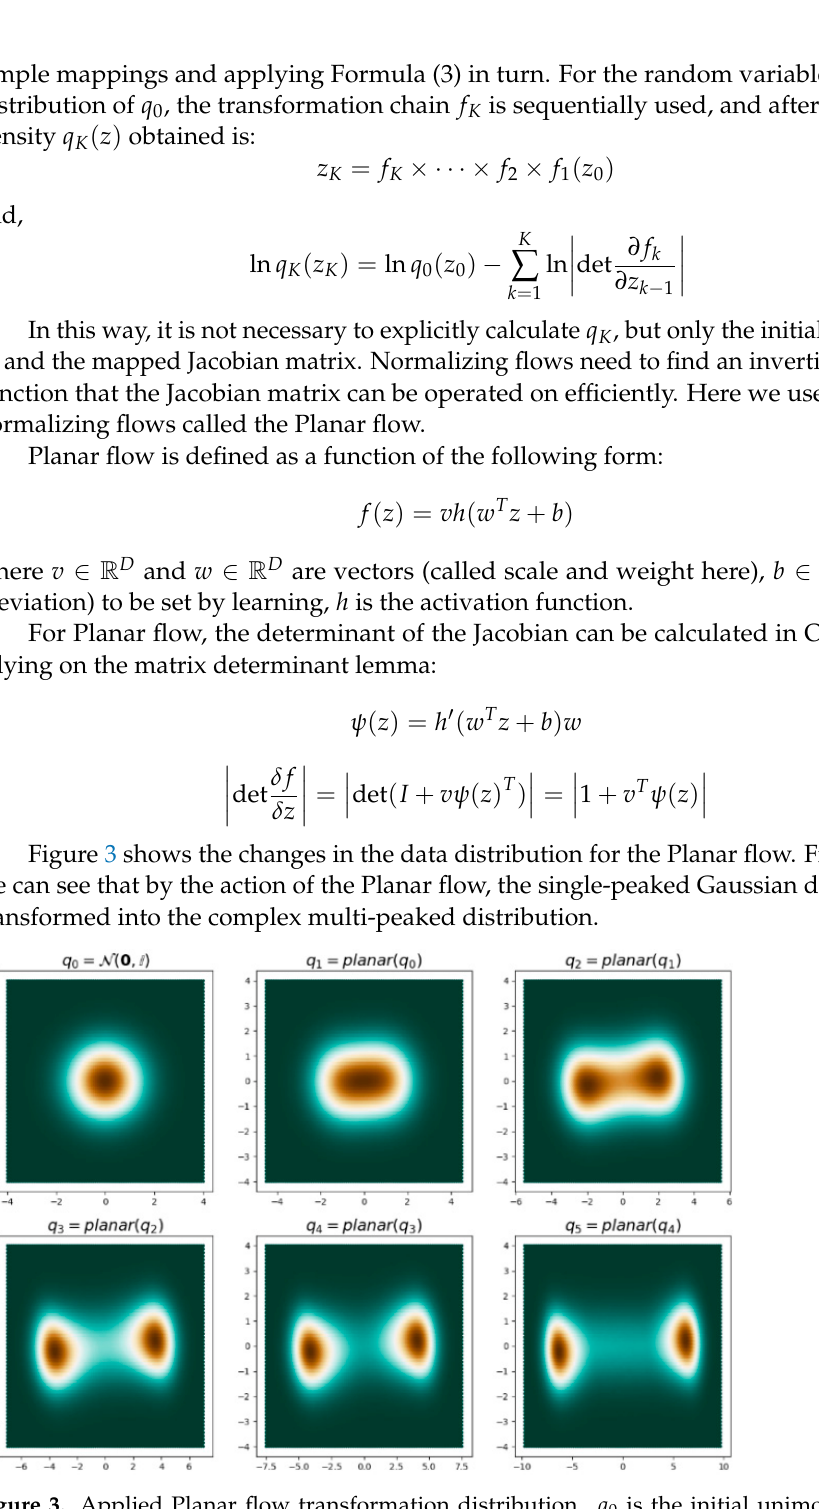
Figure 3. Applied Planar flow transformation distribution. q 0 is the initial unimodal Gaussian distribution, q 5 is the bimodal distribution obtained by Planar